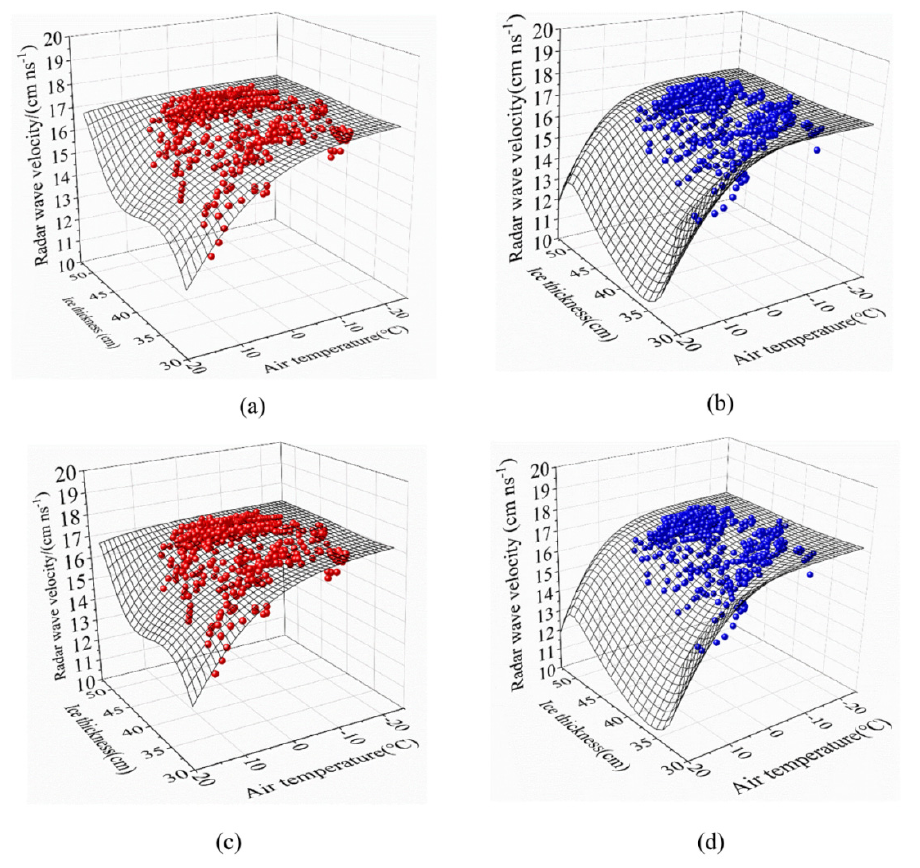
Figure 10. Fitting surfaces of radar wave velocity in ( a , b ) granular and ( c , d ) columnar ice changing with air temperature and ice thickness in ( a , c ) warming and ( b , d ) cooling processes of air tempera-